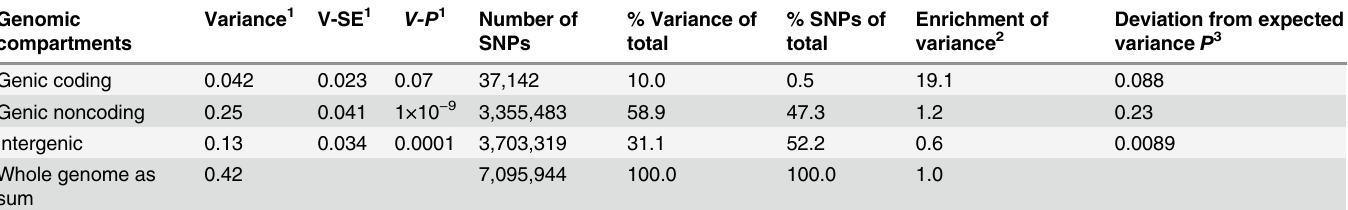
Table 1. Heritability of MI/CAD explained by three genomic compartment sets. We calculated the SNP-heritability in three genomic compartment sets for MI/CAD in a meta-analysis of the MIGen and WTCCC CAD studies using the Genome-wide Complex Trait Analysis (GCTA) software. We observed increased enrichment in variance in both “ genic coding ” and “ genic noncoding ”